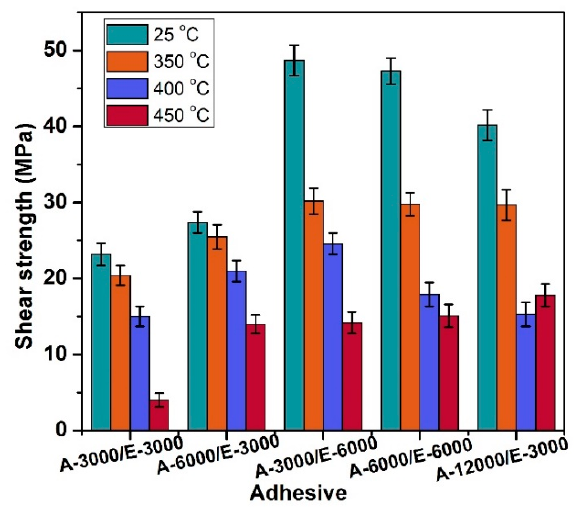
Figure 7. The shear strength of samples treated at different